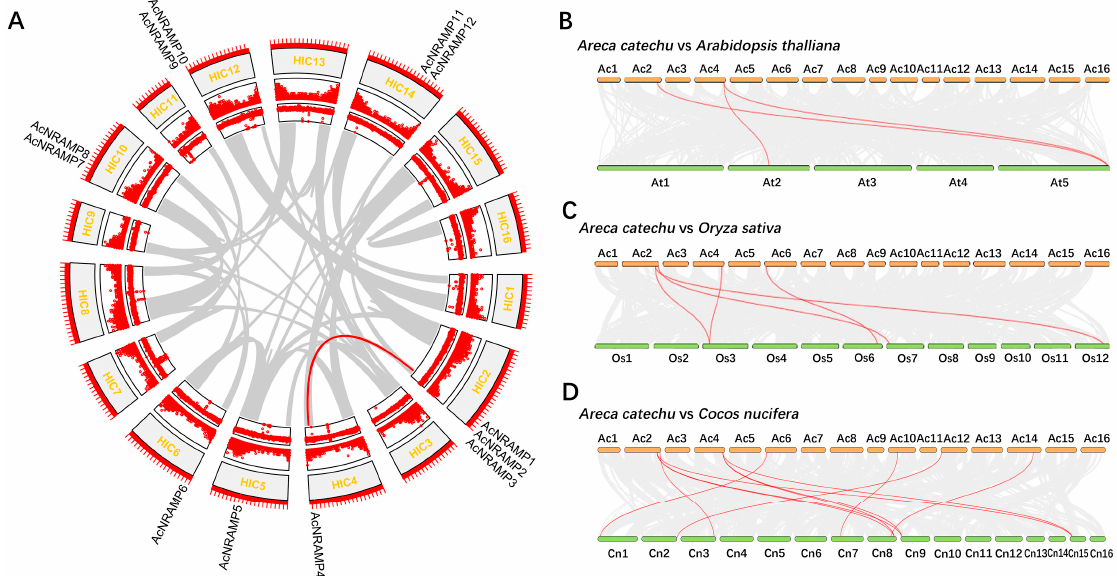
Figure 2. Chromosomal location of AcNRAMP genes. ( A ) Chromosomal location of AcNRAMP s and their collinear gene pairs in A. catechu genome. The outer ring to the inner ring represents 16 chromosomes, gene density, and GC contents, respectively. ( B – D ) Syntenic analysis of AcNRAMP s between A. catechu and A. thaliana , A. catechu and O. sativa , and A. catechu and C. nucifera , respectively. The gray lines among each chromosome represent all gene pairs between A. catechu and other plant species, while the red lines represent the gene pairs associated with AcNRAMP genes.